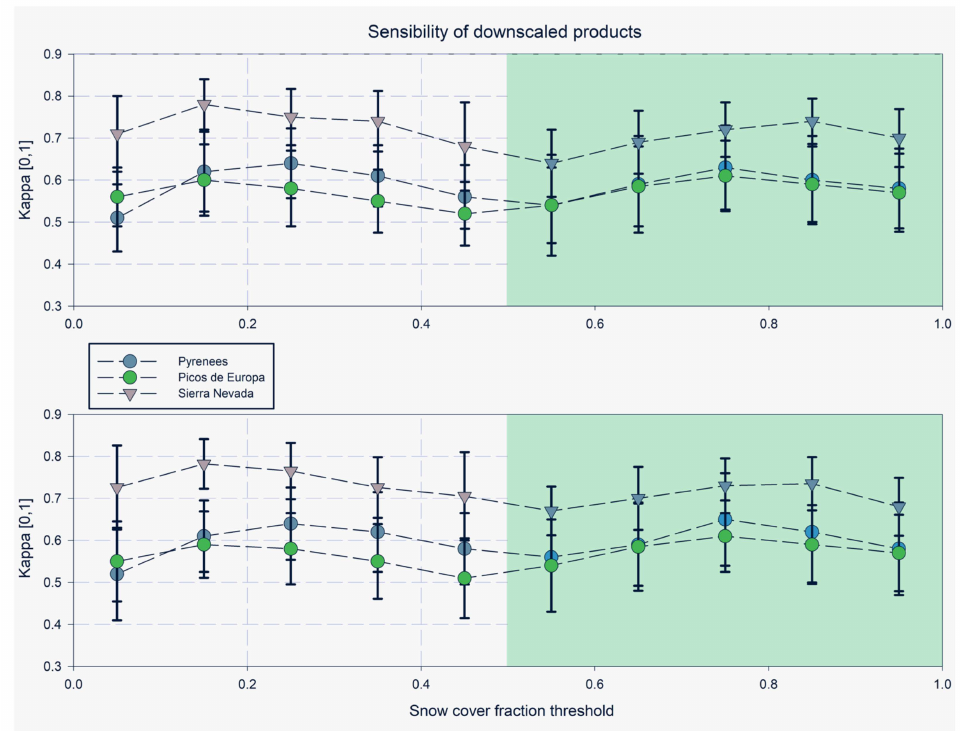
Figure 5. The mean value and standard deviation of the Kappa coefficients obtained in the paired sensi- tivity test to determine the upper and lower FSC thresholds. The upper graph depicts the ProbMODIS sensitivity test, and the lower graph shows the ProbSentinel sensitivity test. The light green shaded area shows the results for the upper limit sensitivity tests, and the non-shaded area the results of the lower limit sensitivity test. These graphs include the results obtained in the three test areas.